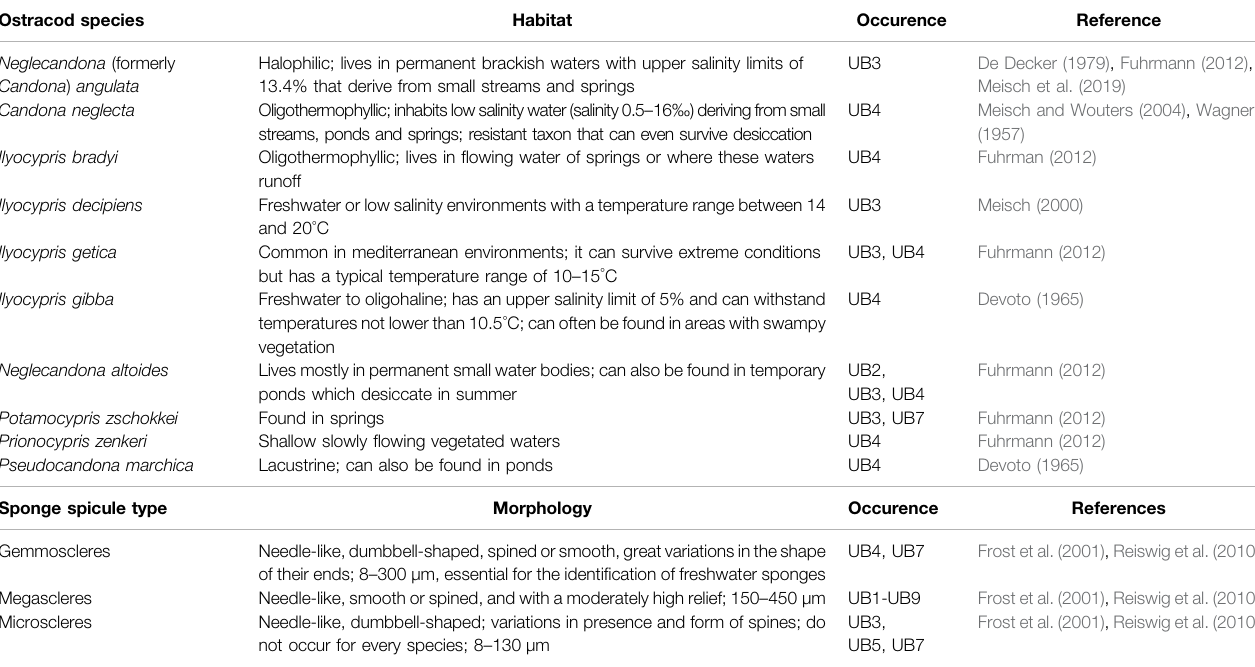
Needle-like,dumbbell-shaped,spinedorsmooth,greatvariationsintheshape UB4, UB7 Frost et al. (2001), Reiswig et al. (2010) of their ends; 8 – 300 μ m, essential for the identi fi cation of freshwater sponges Needle-like, smooth or spined, and with a moderately high relief; 150 – 450 µm UB1-UB9 Frost et al. (2001), Reiswig et al. (2010) Microscleres Needle-like, dumbbell-shaped; variations in presence and form of spines; do not occur for every species; 8 – 130